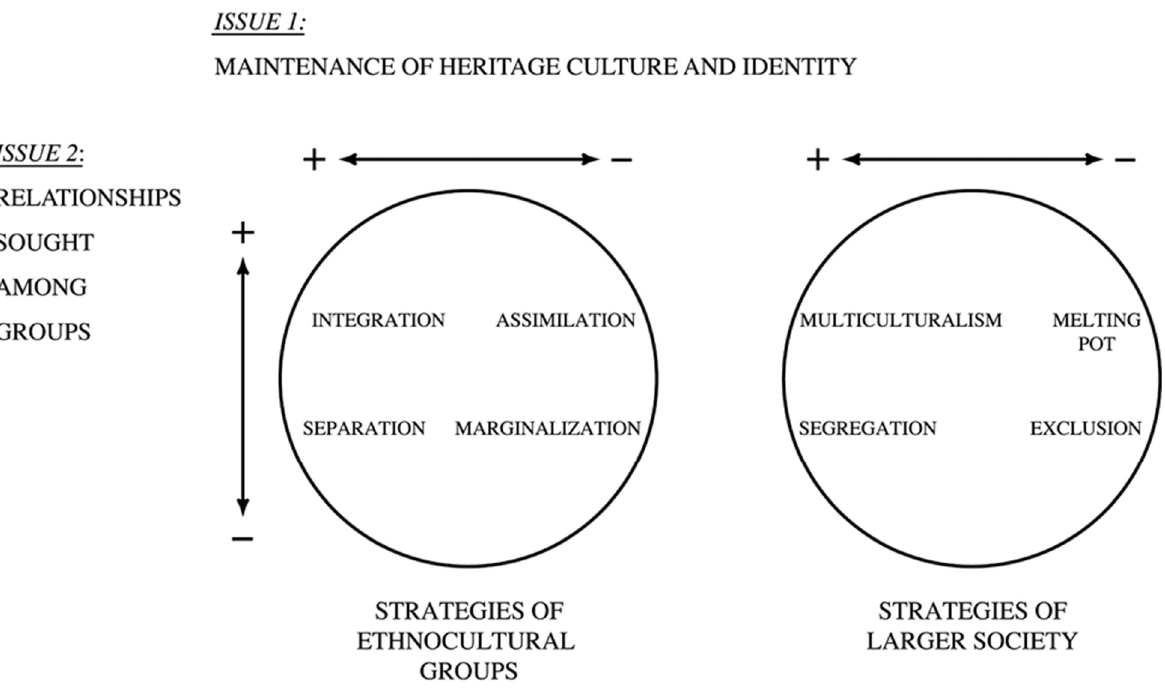
Figure 3. Framework for Examining Acculturation Strategies and Expectations in Ethnocultural Groups and the Larger Society.